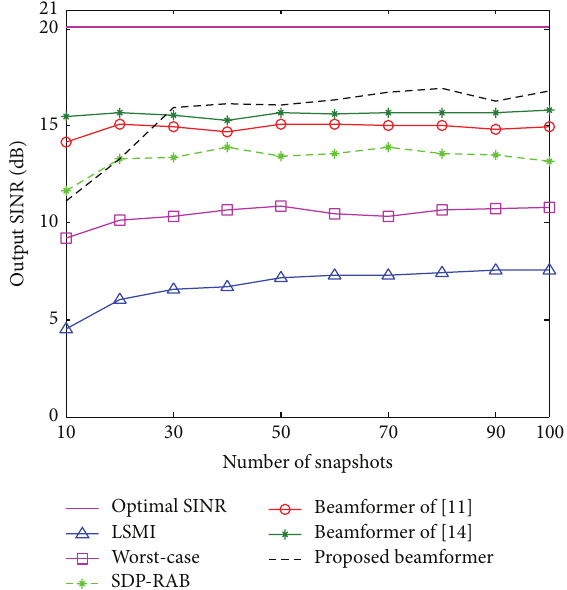
Figure 12: Output SINR of beamformers versus snapshots with arbitrary ASV